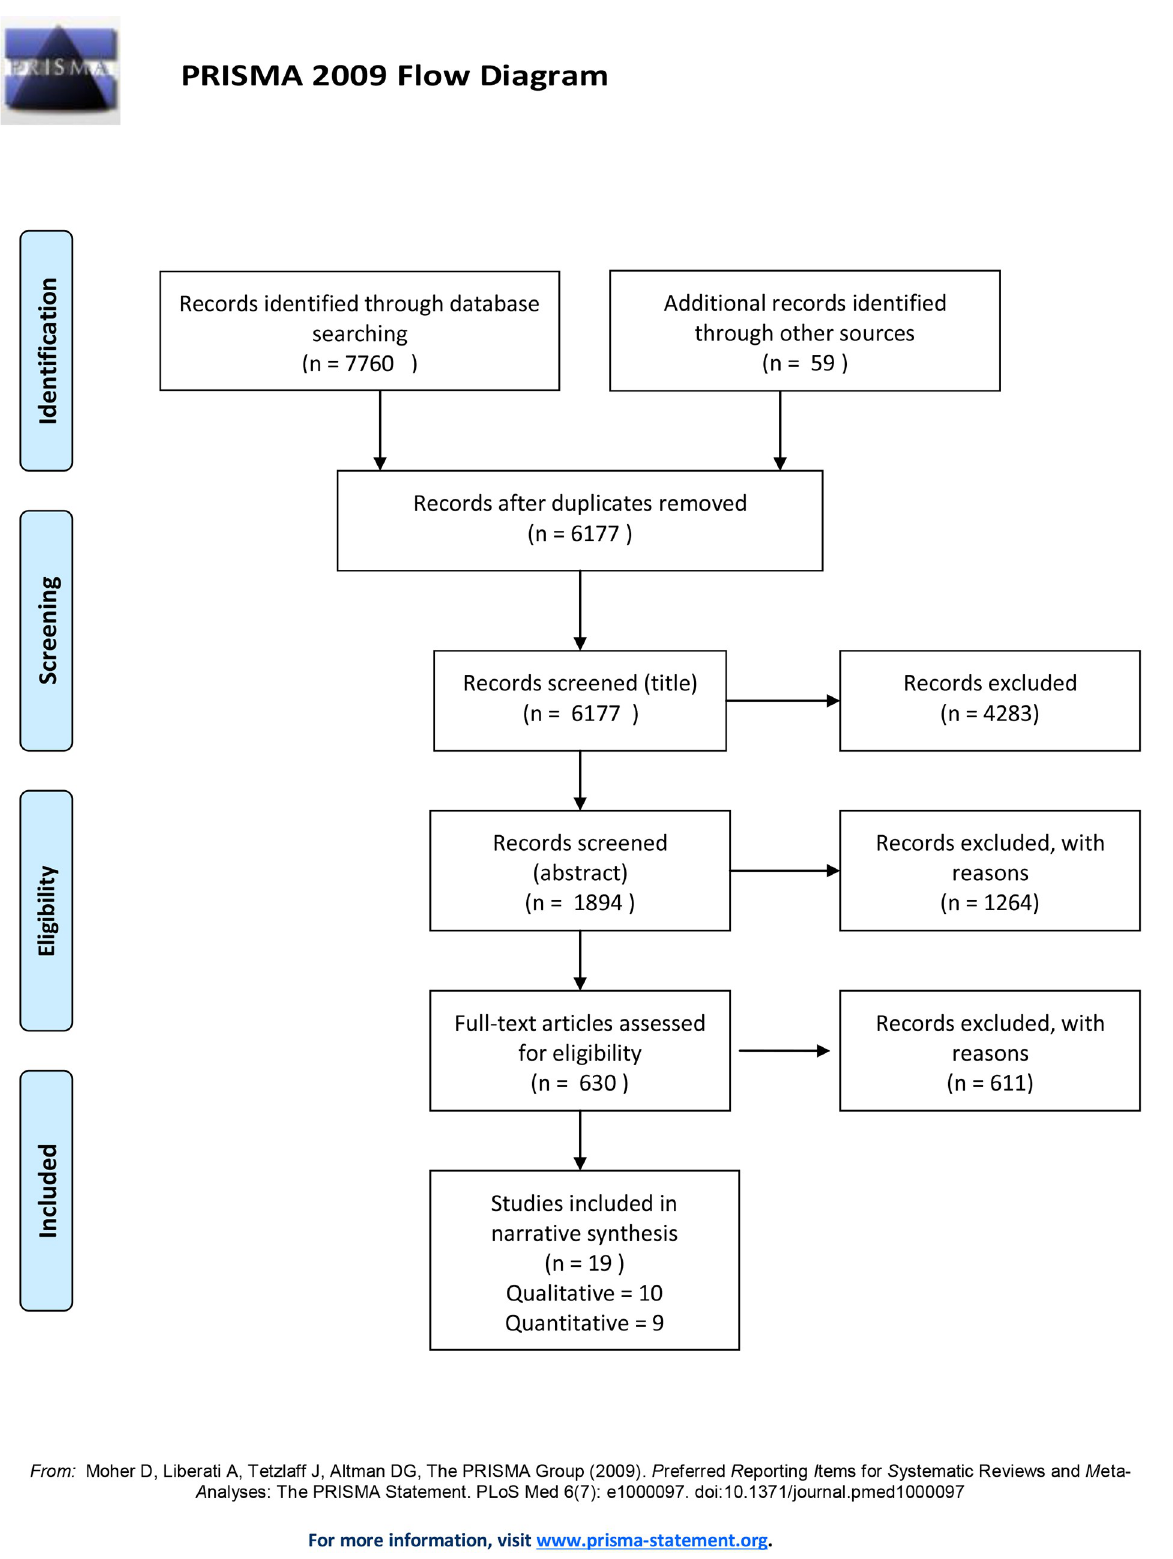
Fig 2. PRISMA flow diagram. https://doi.org/10.1371/journal.pone.0232401.g002 PLOS ONE | https://doi.org/10.1371/journal.pone.0232401 June 9,